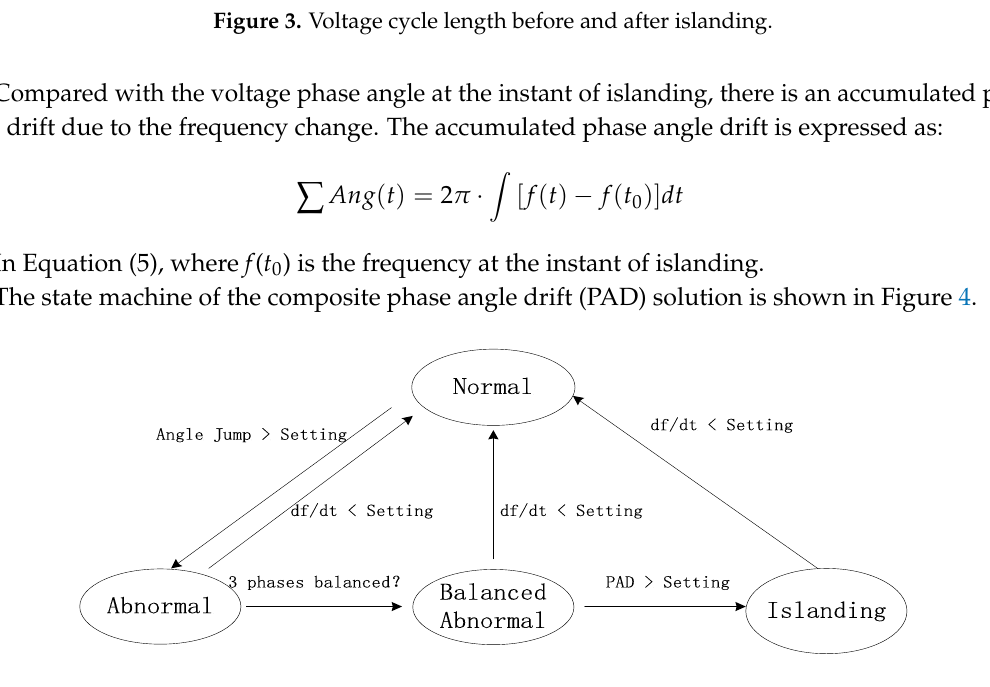
Figure 3. Voltage cycle length before and after islanding.